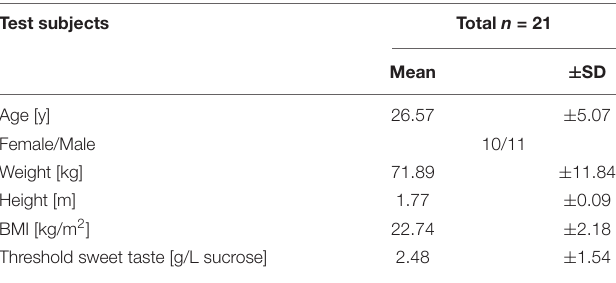
TABLE 2 | Characteristics of the study